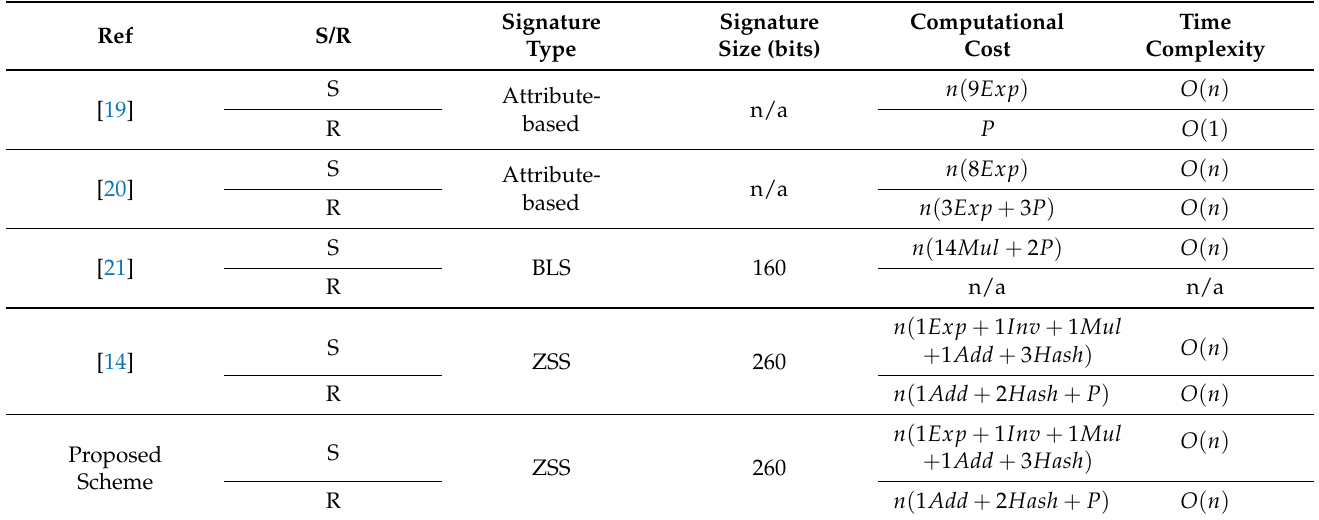
Table 3. Computational cost and time complexity